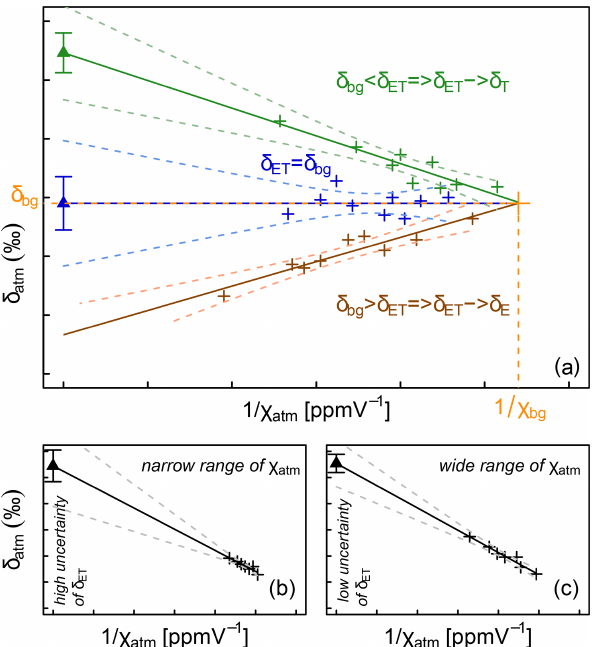
Figure 4. Illustration of the Keeling (1958) plot technique for deter- mination of the isotopic composition of the surface flux, here evapo- transpiration ( δ ET ). Subscript “bg” refers to the atmospheric back- ground air, i.e. the air, which is not influenced by the surface ET flux. (a) Cases with different slopes of the regression line and im- plications for the nature of the surface flux: ET tends either toward transpiration ( T ) or evaporation ( E ). Illustration of the importance of the (narrow or wide) spread in values of the water vapour mixing ratio ( χ atm , ppmV) for the uncertainty of the δ ET estimate (b,c)